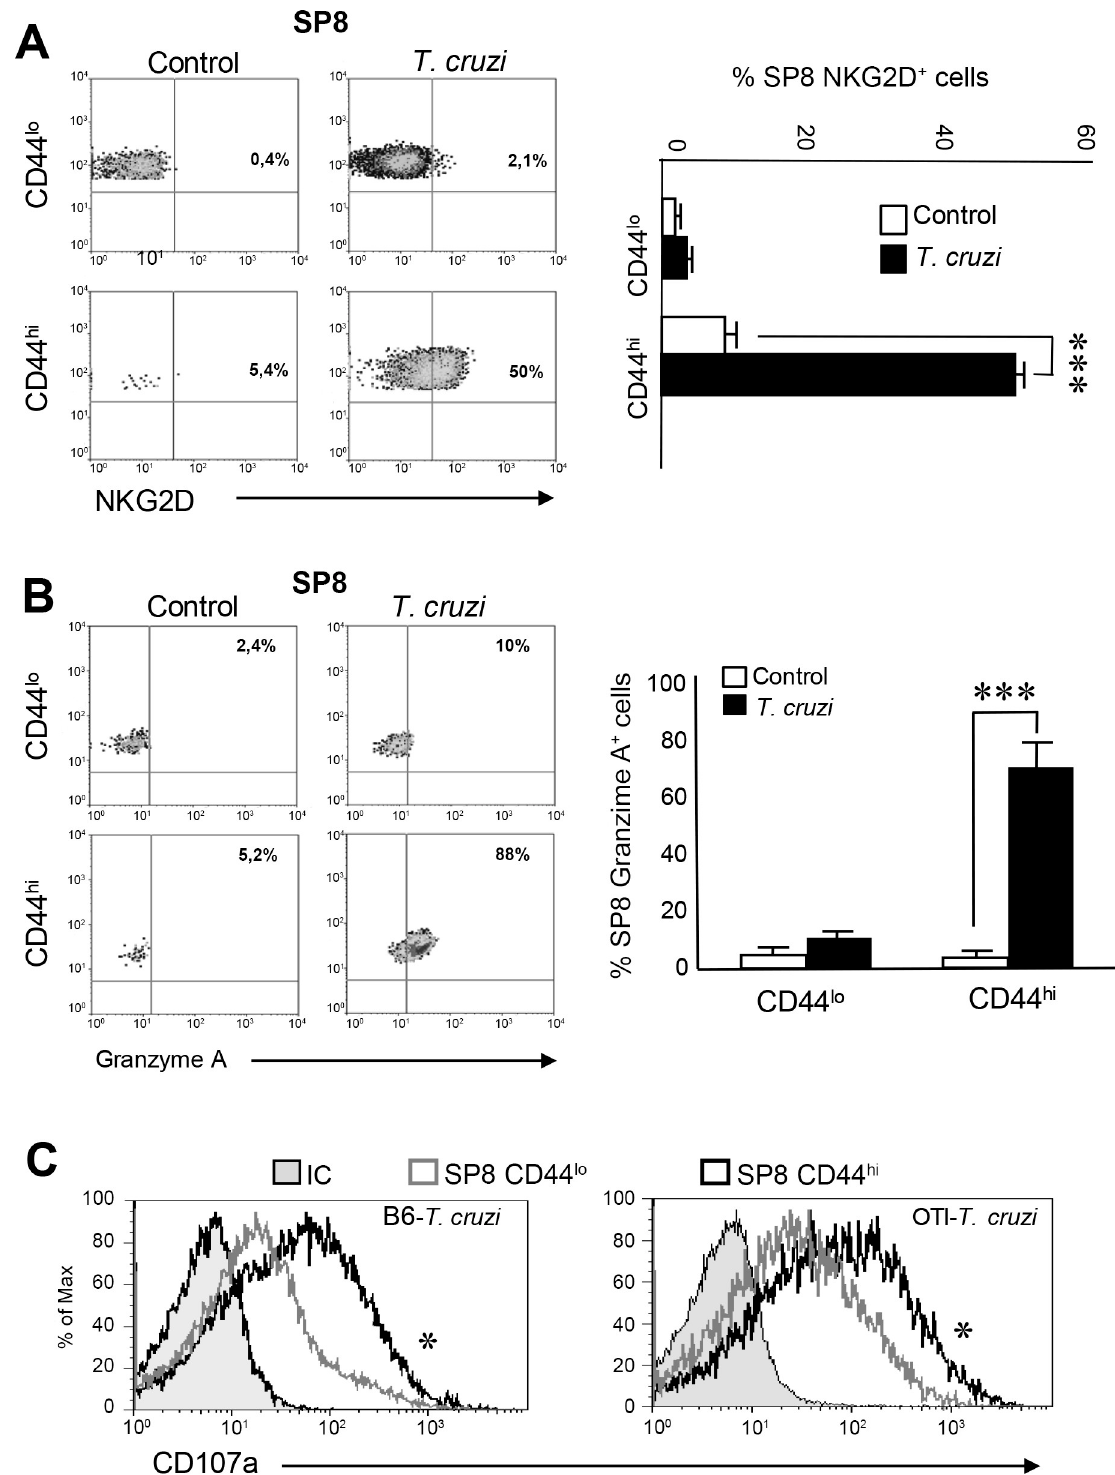
Fig 7. SP8 CD44 hi thymocytes from T . cruzi -infected mice adopt cytotoxic features. (A) The percentage of SP8 NKG2D + cells or (B) SP8 Granzyme A + cells were analyzed by Flow cytometry in CD44 hi and CD44 lo thymocytes isolated from control or T . cruzi -infected (Tulahuen) WT mice. Dot plots are representative of one mouse per group from three independent experiments with 4–6 mice per group. The statistical test applied was a One-way ANOVA. Control versus T . cruzi -infected mice, ��� p < 0 . 001 . (C) Thymi from WT T . cruzi -